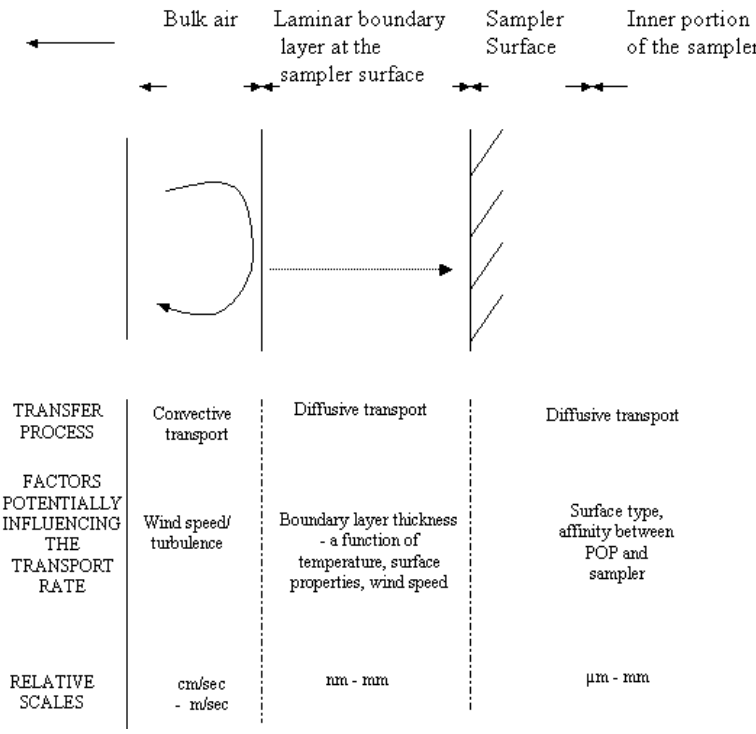
FIGURE 4. More detailed conceptual consideration of gas-phase POP transfer to a